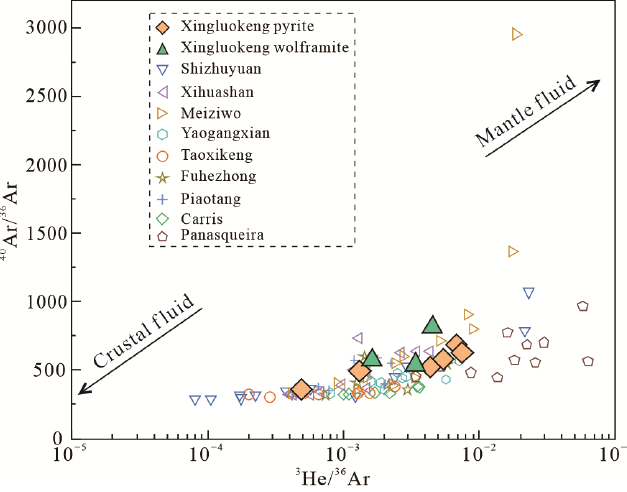
Figure 5. 40 Ar/ 36 Ar vs. 3 He/ 36 Ar plot of the ore-forming fluids from the Xingluokeng W-Mo polymetallic deposit. The figure also shows the published He-Ar isotopic compositions of a number of other W deposits around the world, such as Shizhuyuan [25], Xihuashan [24], Meiziwo [28], Yaogangxian [18], Taoxikeng [27], Fuhezhong, and Piaotang [26] W deposits in south China, and the Carris W-Mo-Sn deposit [22] and Panasqueira in Portugal [20]. The values of mantle fluids and crustal fluids are quoted from [18].